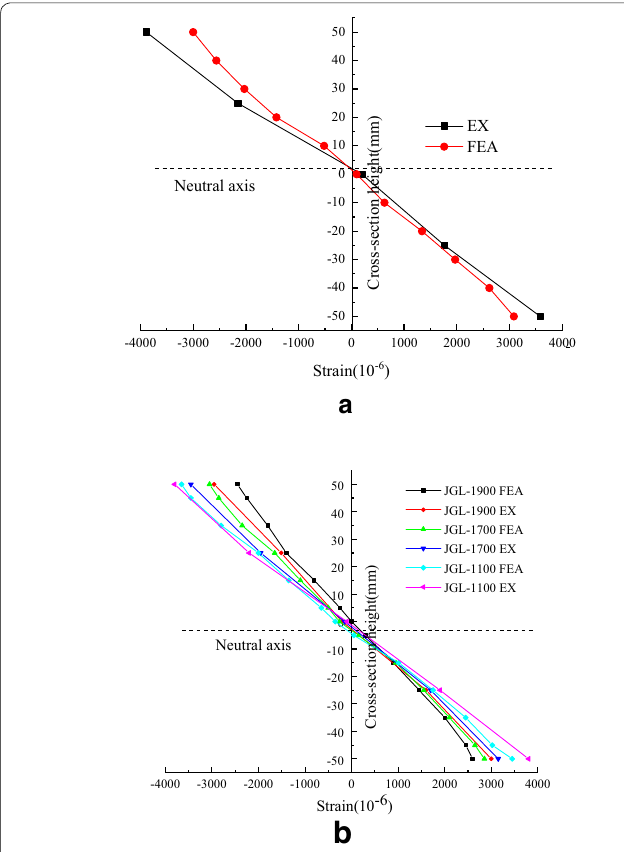
Figure 14 discloses the comparison of strain versus cross- section height for the control beam DBL under the 8.4- kN load and for the strengthened beams with different strengthening configurations under the 10.5-kN load. For the control beam, the neutral axis, based on the numeri- cal analysis and testing results, all moved toward the compression zone with minimal movement. The strain was not completely distributed in a straight line along the section, which can be judged to be in the elastic–plastic stage. In the test under the 10.5 kN load, the neutral axis of all BFRP-strengthened beams shifted downward to the tensile zone, in which the phenomenon is opposite to the control beam. Therefore, BFRP strips can improve a cer- tain stiffness to timber beams during loading. The strain was not completely distributed in a straight line along the section, which also can be considered in the elas- tic–plastic stage. Under the same load, the strain value decreased with the increase of the BFRP bonding length.